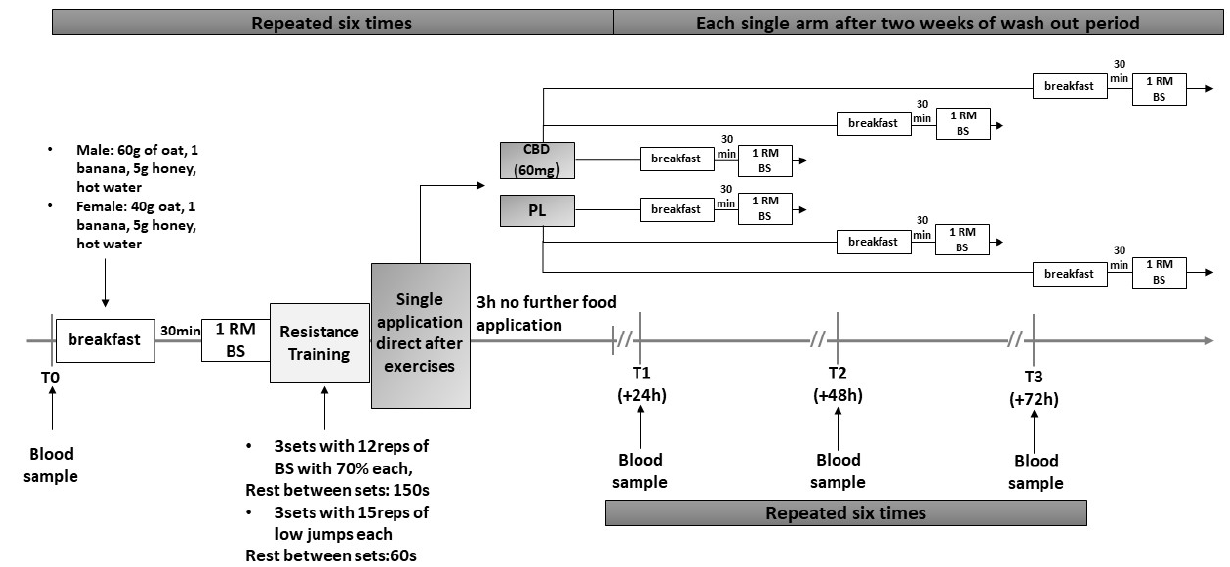
Figure 1. Study design. BS = Back Squat; reps = Repetitions; s = second; 1RM; One-Repetition Maximum; h =